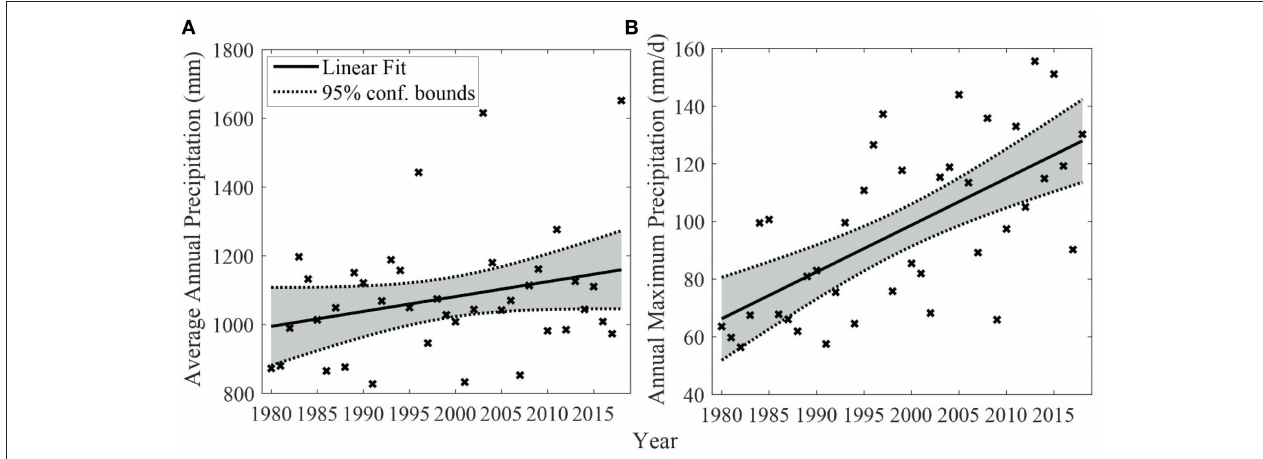
FIGURE 3 | Linear trends during 1980–2018 in (A) annual mean precipitation in mm and (B) annual maximum precipitation in mm/day. Cross markers represent the observed precipitation values for each year and the fitted least square regression line is shown as a solid black line. Dotted lines indicate the upper and lower 95% confidence bounds of the regression